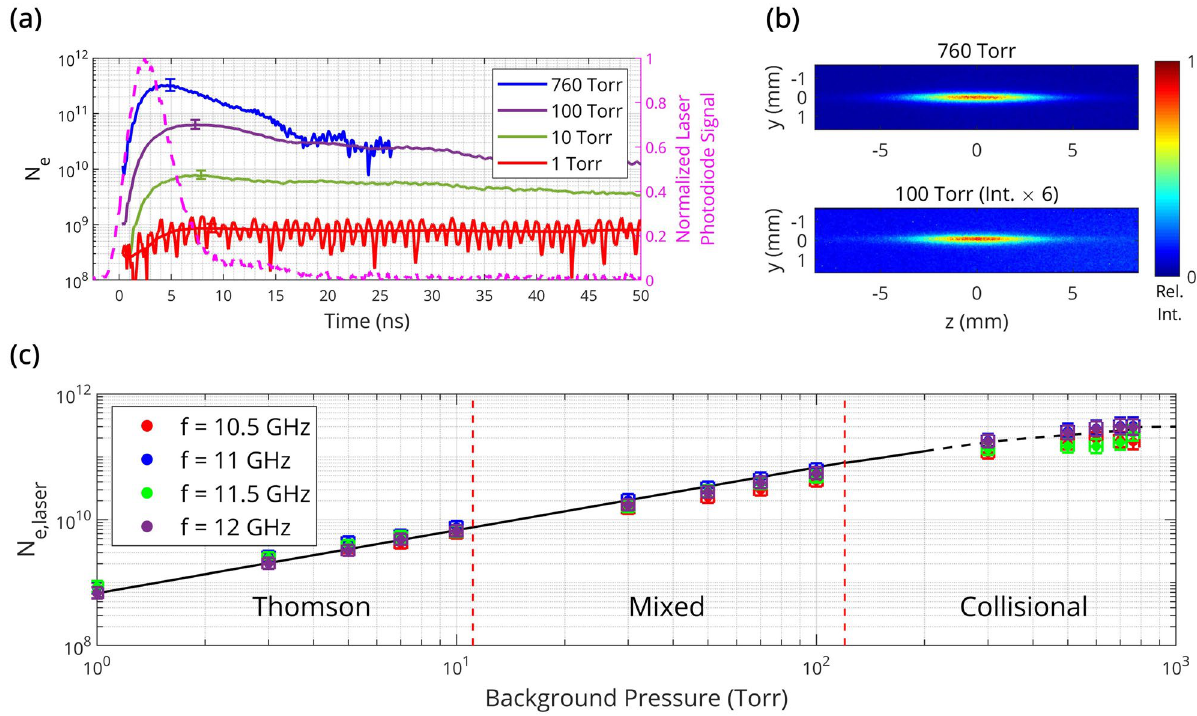
Figure 3. Coherent MS measurements of total electron numbers in variable pressure, short-dipole microplasmas assuming negligible depolarization and skin depth effects. ( a ) Temporal evolution of the total electron number measured via 11 GHz microwave scattering with the dielectric scatterer calibration technique at 1, 10, 100, and 760 Torr (with error bars)—alongside ( b ) line-of-sight intensified charge-coupled device images (gate width 100 ns) of the corresponding laser-induced plasmas. ( c ) Total number of electrons produced by the laser (approximated by the peak N e value, which holds particularly well in the solid black-line region P 100 Torr) as a function of background pressure for 10.5, 11, 11.5, and 12 GHz microwave scattering (with error